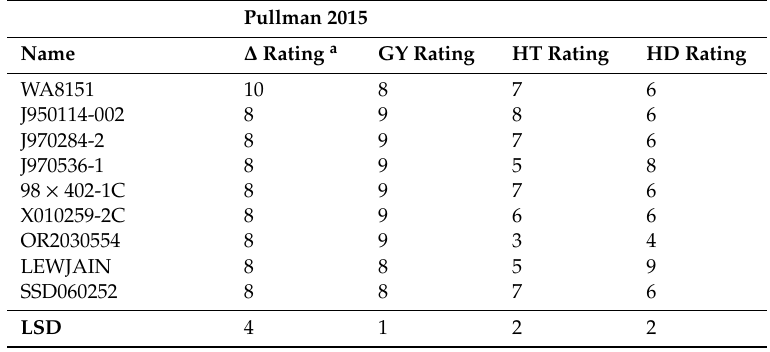
Table 3. High ∆ , high grain yield genotypes from each Pacific Northwest environment, including